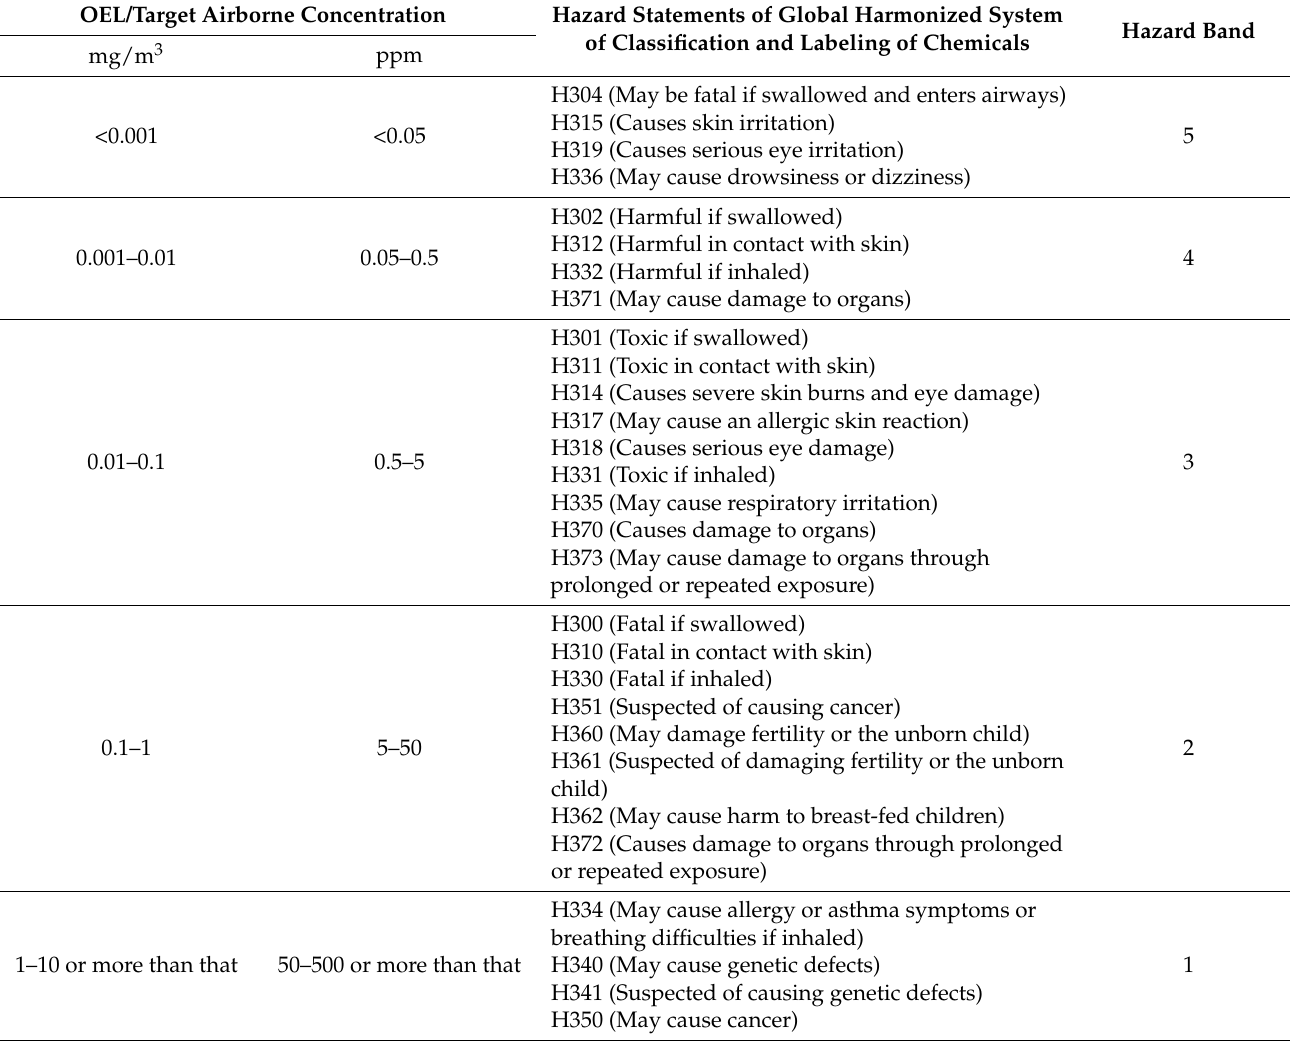
Table 2. Allocation of hazard statements to hazard bands and the associated target airborne concentration ranges represented by occupational exposure limits (OELs).